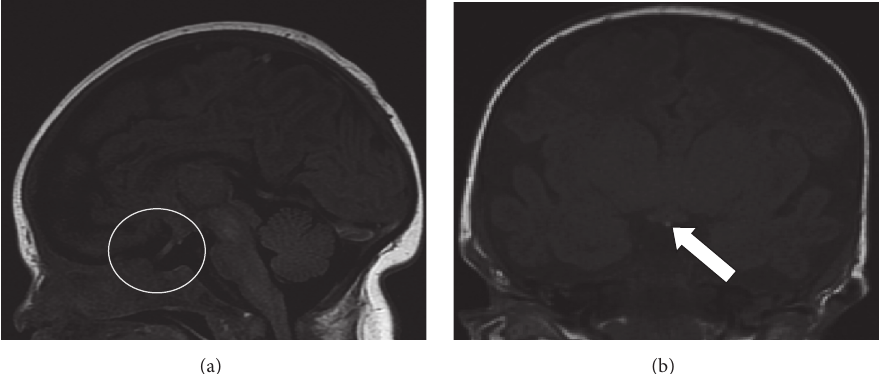
Figure 4: (a) MRI. Sagittal view demonstrates no evidence of the sella turcica and no pituitary soft tissue within the presumed area of the sella. (b) MRI. Coronal view demonstrates a superiorly displaced T1 bright spot consistent with an ectopic posterior pituitary.